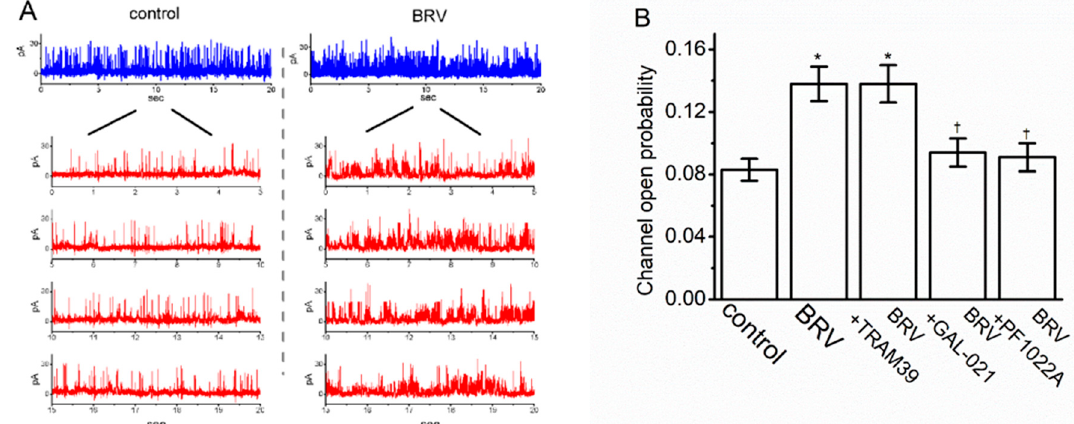
Figure 6. Stimulatory effect of BRV on the activity of the large-conductance Ca 2+ -activated K + (BK Ca ) channels in GH 3 cells. In this set of inside-out current recordings, the cells were immersed in a high-K + solution containing 1 µM Ca 2+ , where the holding potential was clamped at +60 mV. ( A ) Representative BK Ca -channel traces (blue color) obtained in the control (i.e., BRV was not present) (left side of the figure) and after the bath addition of 10 µM of BRV (right side of the figure). It should be noted that the upward deflection shows the channel opening event. The lower part (red color) of the figure shows the expanded records taken from the uppermost part of the figure; ( B ) Summary bar graph showing the open-state likelihood of the presence of BK Ca channels in the presence of BRV (10 µM), BRV (10 µM) plus TRAM39 (3 µM), BRV (10 µM) plus GAL-021 (3 µM), and BRV (10 µM) plus PF1022A (3 µM) (mean ± SEM; n = 7–8). The channel activity was measured when the membrane patch was maintained at +60 mV. * Significantly different from the control ( p < 0.05) and Ɨ significantly different from the 10 µM BRV-alone group ( p < 0.05).